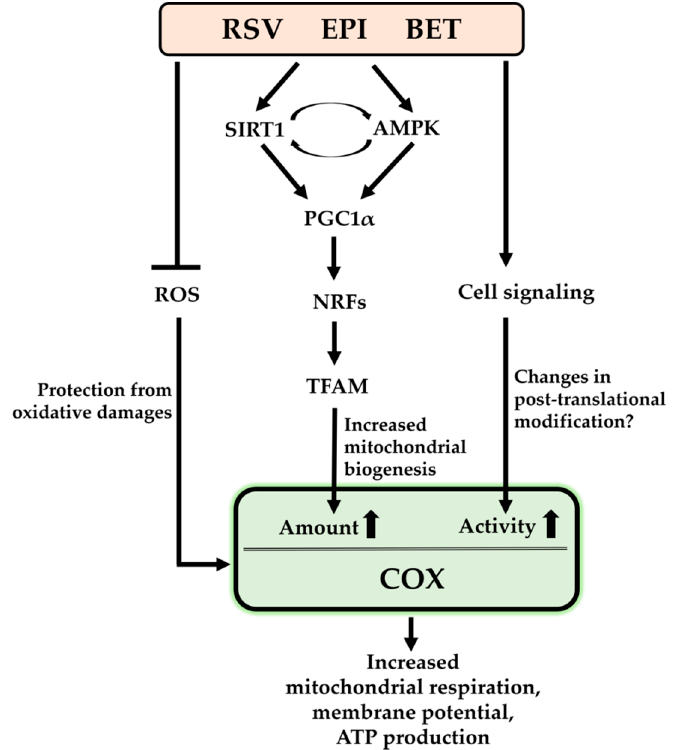
Figure 2. Regulatory mechanisms of resveratrol (RSV), ( − )-epicatechin (EPI), and betaine (BET) on cytochrome c oxidase (COX): ROS, reactive oxygen species; SIRT1, sirtuin 1; AMPK, AMP activated protein kinase; PGC1 α , peroxisome proliferator activated receptor gamma coactivator 1 alpha; NRFs, nuclear respiratory factors; TFAM, mitochondrial transcription factor A.